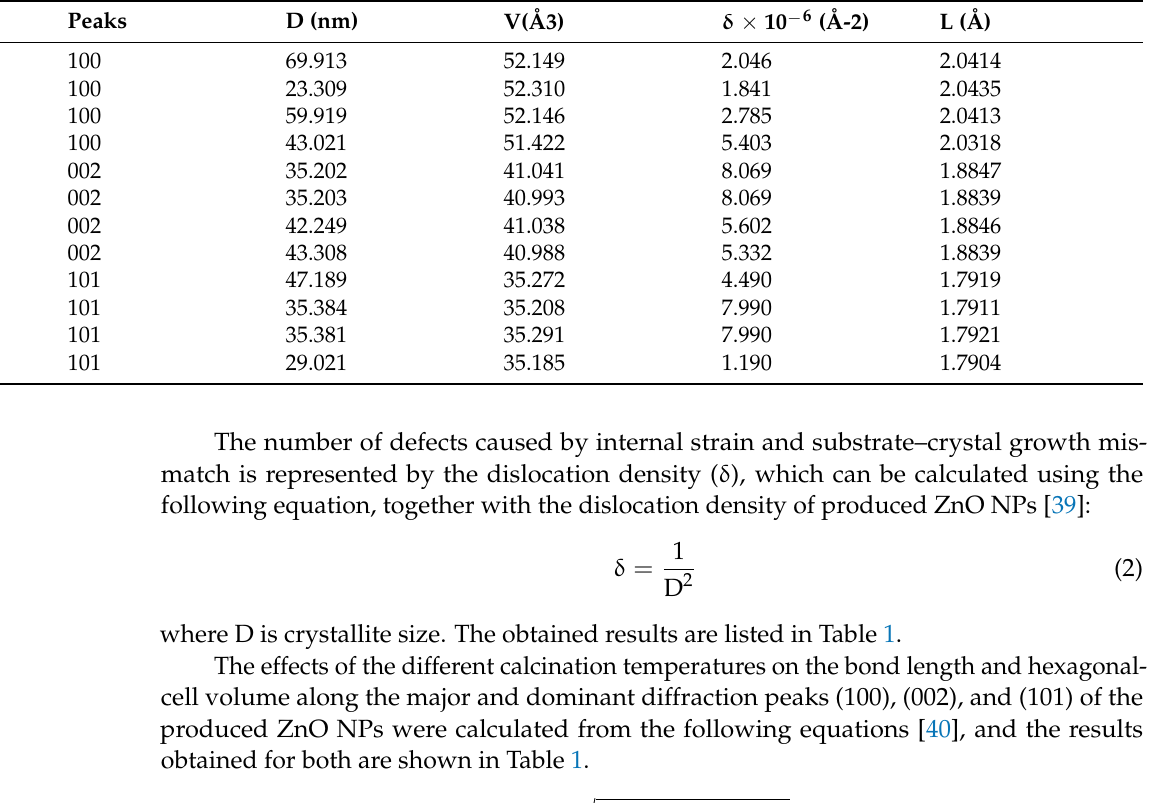
Table 1. The particle size, volume, dislocation density, and bond length at stronger diffraction peaks for the (100), (002), and (101) planes of the ZnO nanoparticles synthesized at different calcination